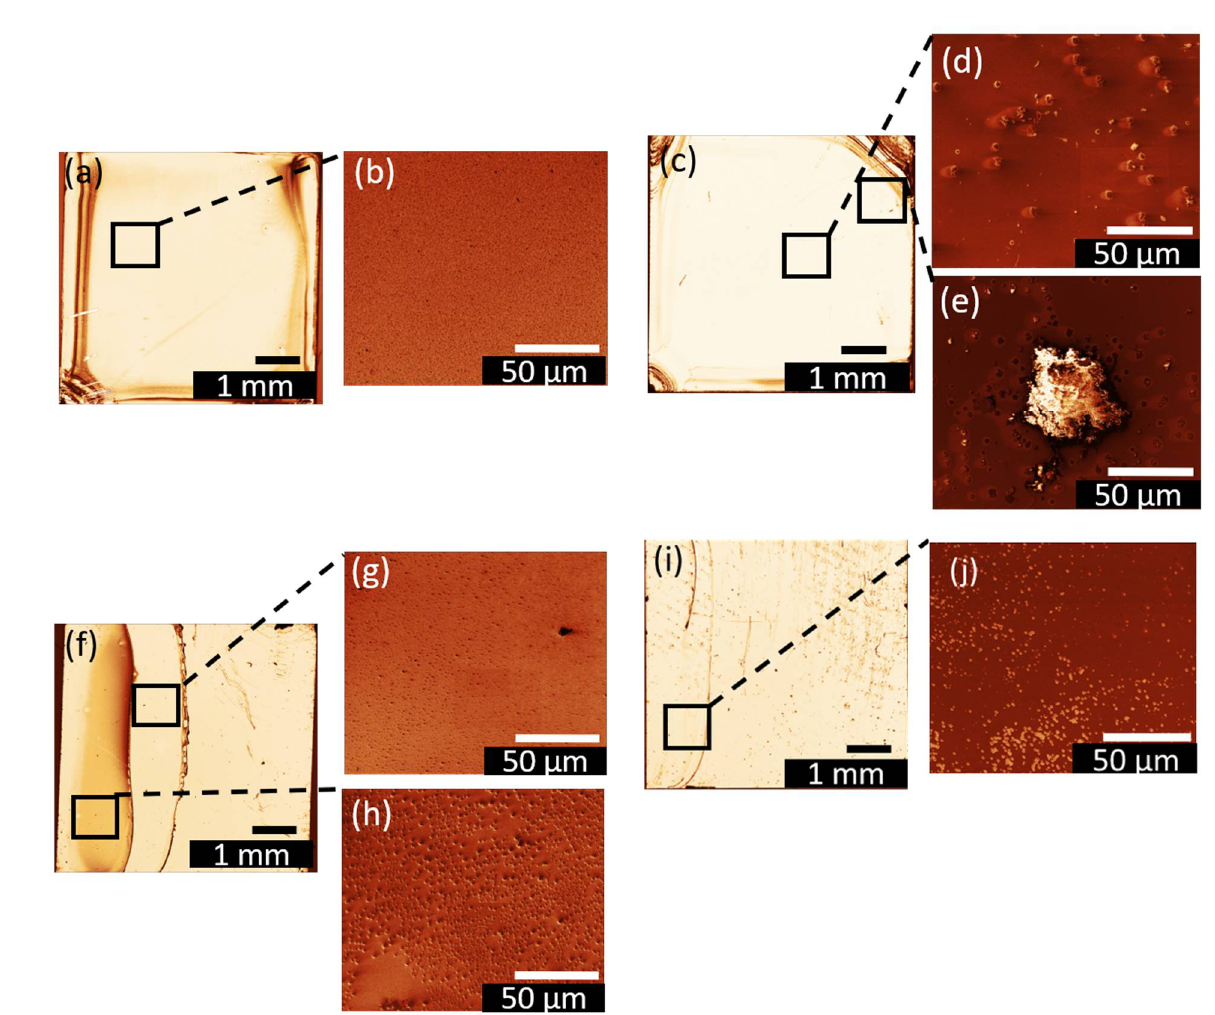
Figure 8. Light microscopy images with insets from SEM images of spin- and dip-coated films treated with the Gwyddion.net image filter from Gwyddion software for ( a ), ( b ) 2 –SpE, ( c – e ) 2 –SpA, ( f – h ) 2 –DiE and ( i ), ( k ) 2